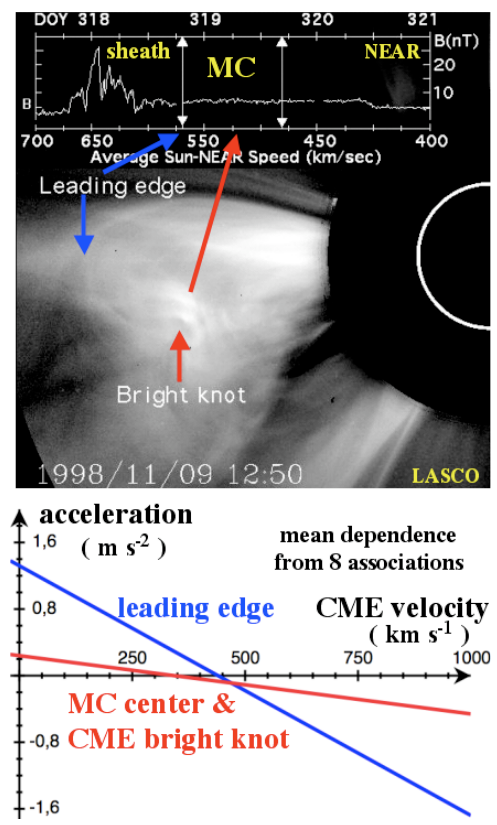
Fig. 4. Acceleration of MCs from observations in quadrature. The top panel shows a limb CME observed by LASCO with the asso- ciated in-situ measurements of the magnetic field strength by the NEAR spacecraft added on the top part. The abscissa is the arrival time (in days, upper axis); the corresponding mean transit velocity is reported on the lower horizontal axis. From the mean velocity, the radial velocity measured with LASCO and the transit time, a mean acceleration is computed. The least-squares fit of a straight line to the data results of 8 associations is shown in the bottom panel (Rust et al.,